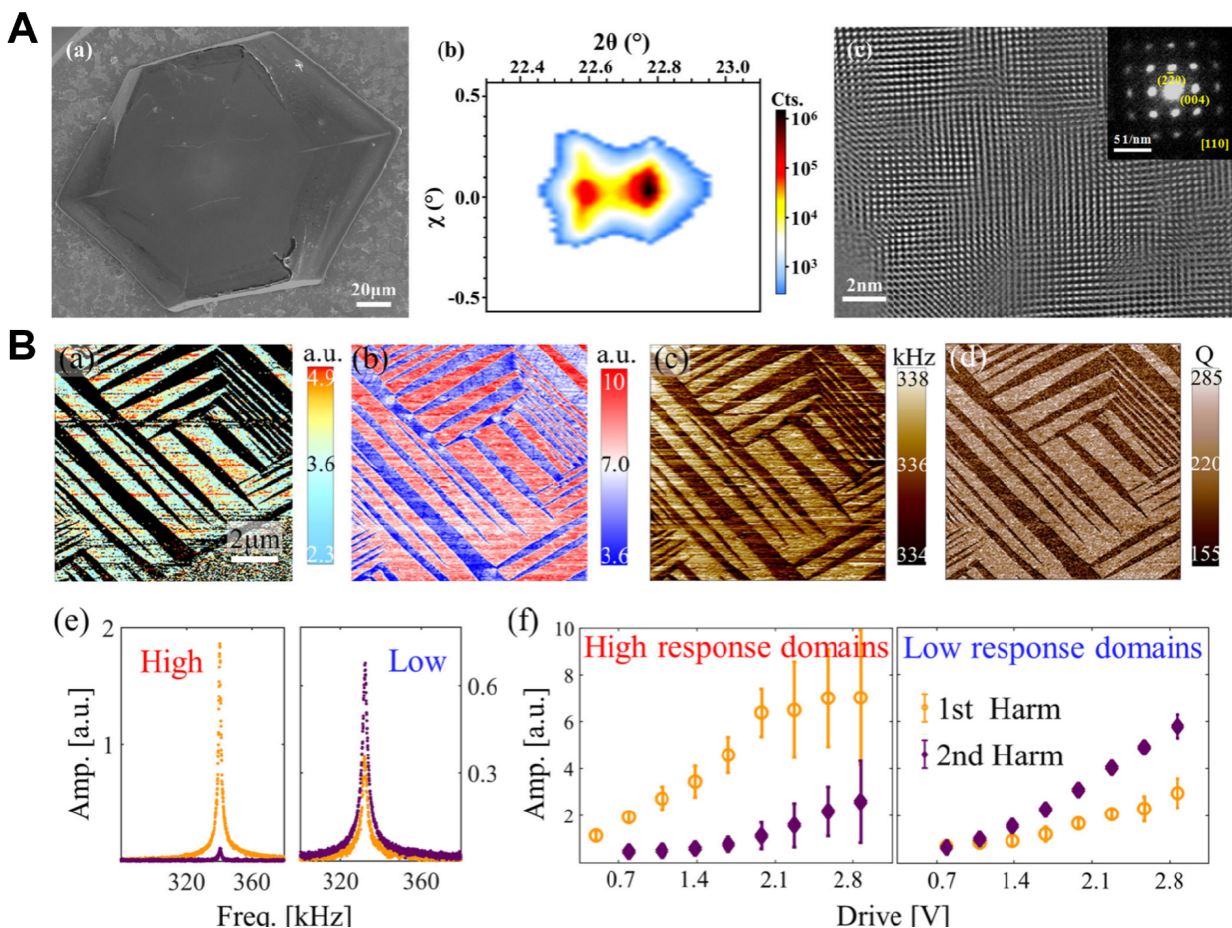
Figure 4. ( A ). Single-crystalline CH 3 NH 3 PbI 3 directly grown on FTO/TiO 2 substrates: ( a ) top view SEM image; ( b ) selected reflections from synchrotron XRD integrated over a rocking angle range of 1 degree; and ( c ) HRTEM image with the corresponding selected area’s electron diffraction pattern as inset. ( B ). Alternating polar and nonpolar domains in CH 3 NH 3 PbI 3 crystal: ( a ) Lateral PFM mapping showing complete failure of SHO (marked by black dots) in nonpolar domains due to their lack of true piezoelectricity; ( b ) Vertical PFM mappings showing identical domain pattern consisting of high-response polar domains and low-response nonpolar domains; ( c ) Resonant frequency mapping of vertical PFM showing elastic contrast between polar and nonpolar domains and good resonance tracking; ( d ) Quality factor mapping showing substantially lower quality factor and, thus, higher energy dissipation in nonpolar domains; ( e ) Point-wise tuning of piezo-response vs. frequency showing a point in high-response polar domain has dominant first harmonic response and negligible second harmonic one, while a point in low-response nonpolar domain has higher second harmonic response; and ( f ) Comparison of first and second harmonic responses [18].